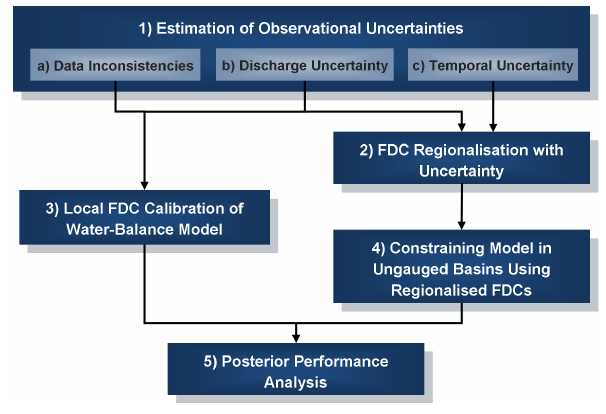
Figure 3. Schematic description of the method used in this